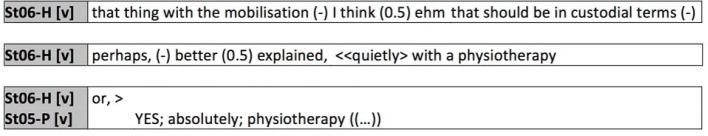
Designation of roles in the conversations